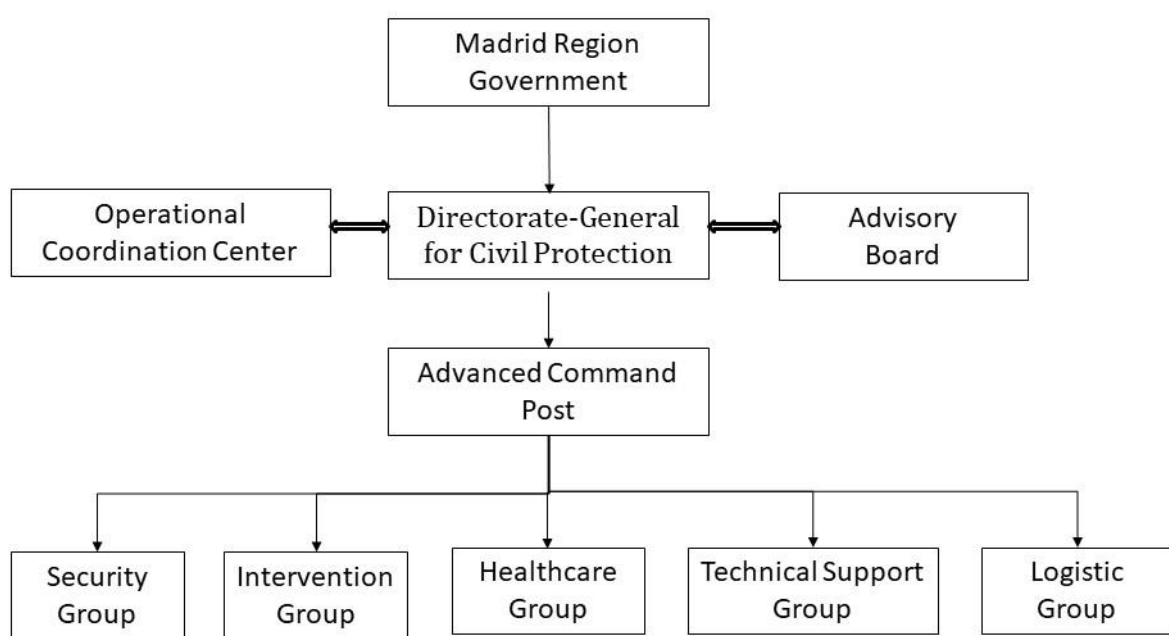
Figure 1. Actors involved in the decision-making process in the emergency system in the Madrid